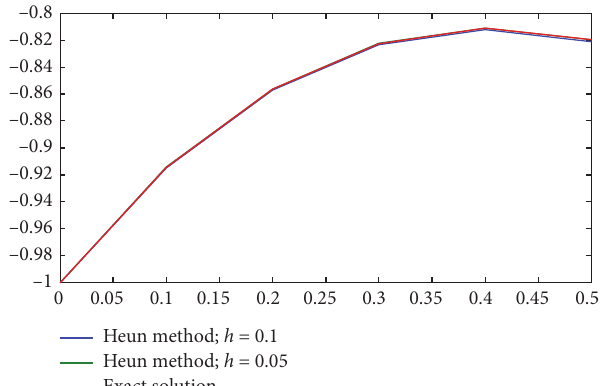
Figure 5: Numerical solution using the proposed method and exact solution for Example 1.